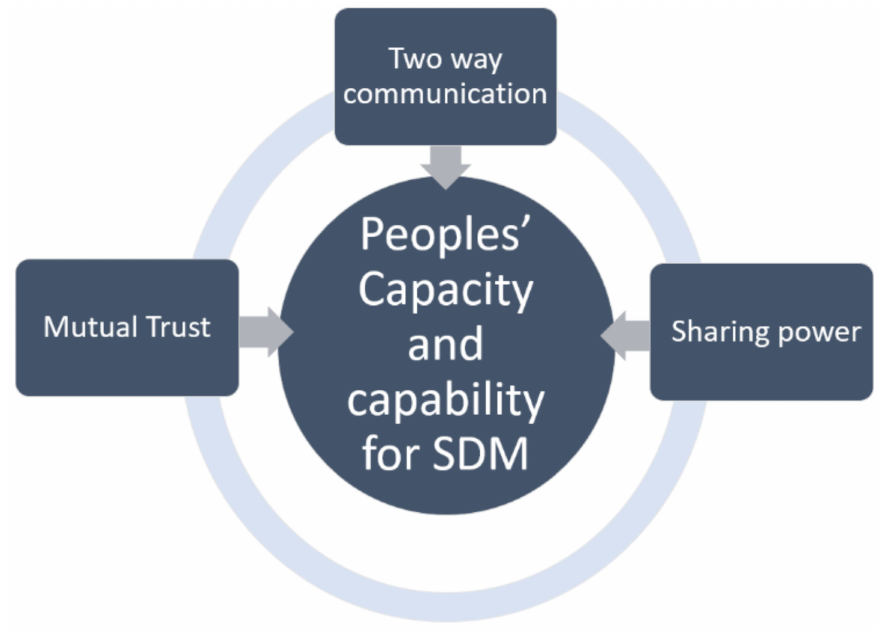
Figure 2. The capacity and capability (CAC) model for enhanced